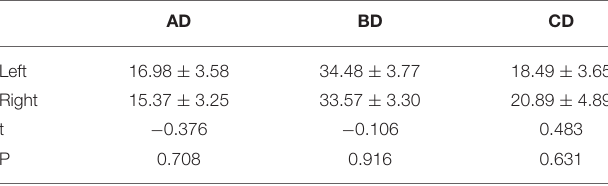
TABLE 1 | The length between anatomical landmarks in dry skulls